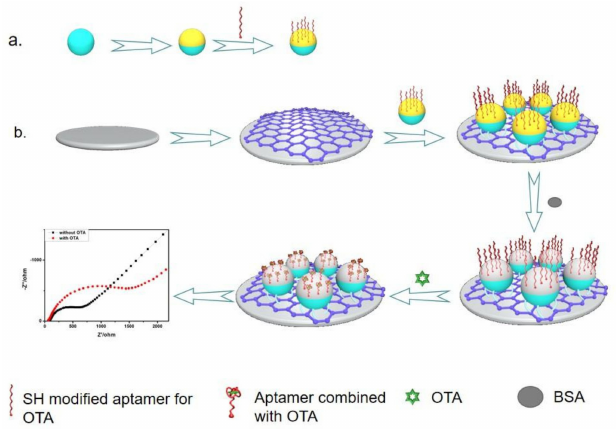
Figure 8. Synthesis strategy of Janus particles ( a ) and the schematic diagram of the sensing principle of the ochratoxin A immunosensor ( b ). Reprinted with permission from ref. [155]. Copyright © 2019 Elsevier